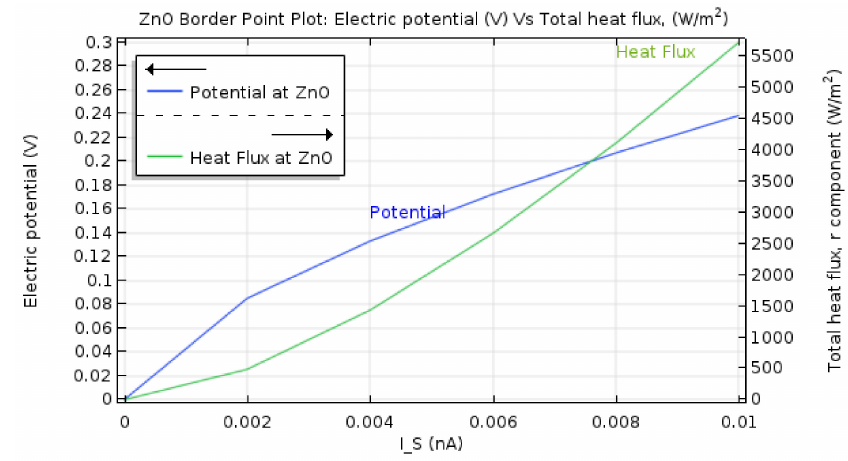
Figure 8. Dielectric layer (ZnO) electrical potential and heat flux